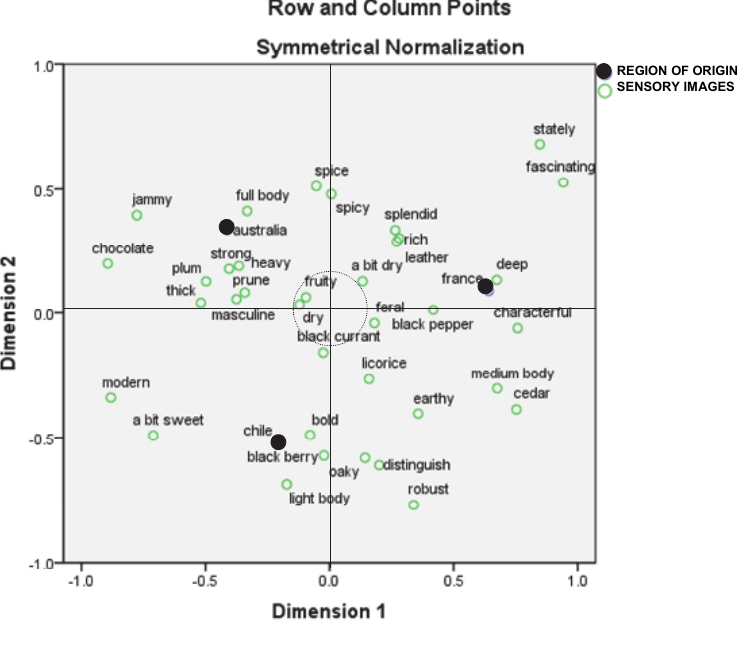
<Figure 1> Wine Sensory Images Correspondence